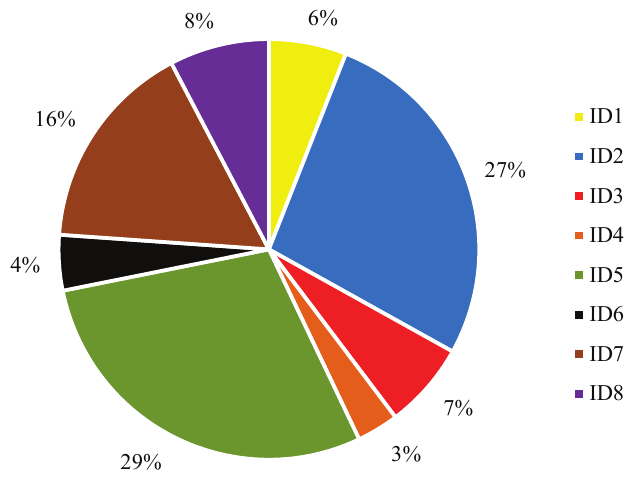
Figure 4. Participation percentage of categories: first